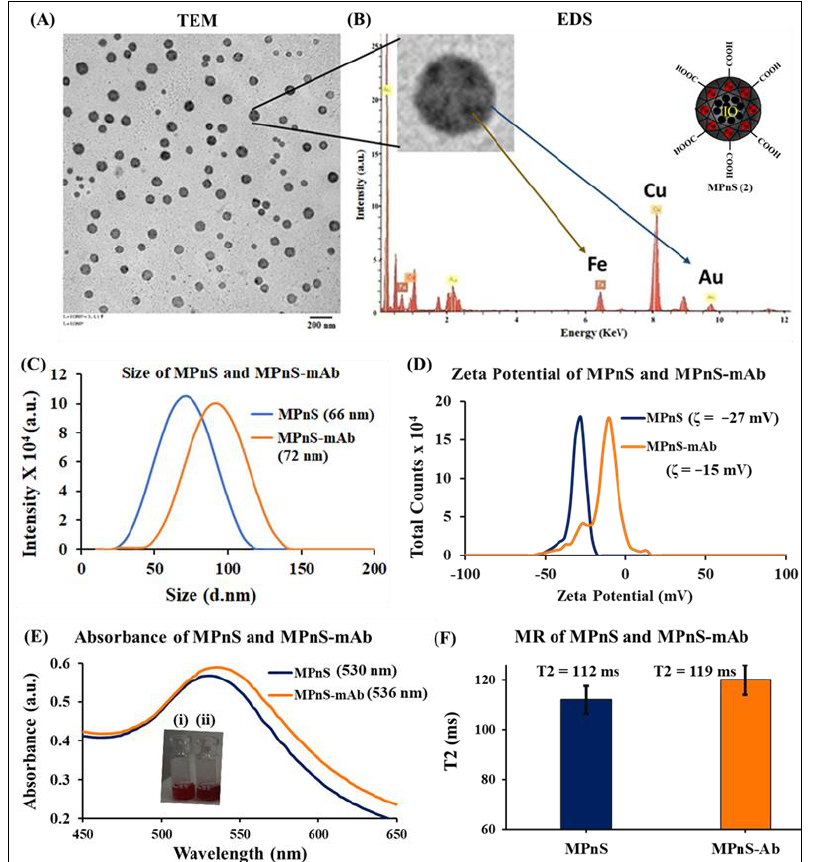
Figure 1. Characterization studies of MPnS and MPnS-mAb conjugates: ( A ) Transmission electron microscopy (TEM) image of MPnS, scale bar: 200 nm. ( B ) Energy-dispersive X-ray spectroscopy (EDS) of MPnS, showing the presence of bimetallic system. ( C ) Plot of hydrodynamic diameter. ( D ) Zeta potential of MPnS before and after surface conjugation. ( E ) UV-Vis absorption spectra of MPnS and the conjugate, confirming the successful antibody conjugation, inset: images of (i) MPnS and (ii) MPnS conjugate solution. ( F ) T2 values before and after surface modification of MPnS.2.7. Conjugation of target-specific antibodies to the surface of MPnS